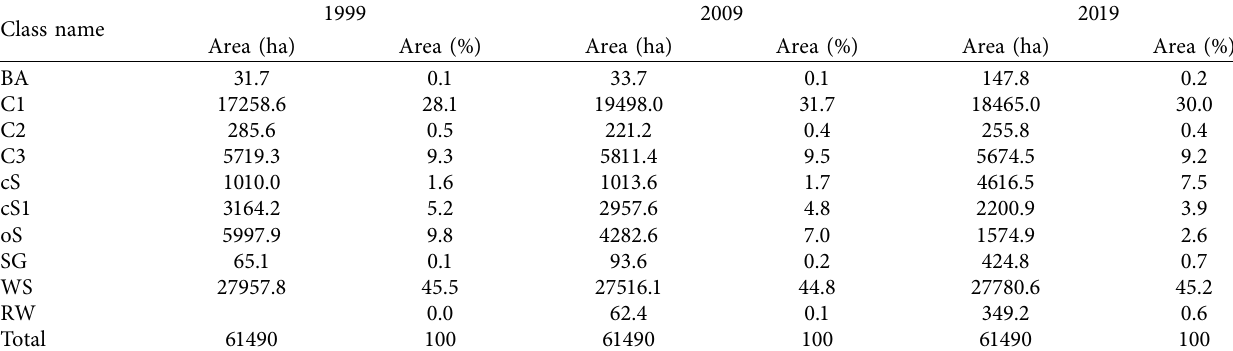
Figure 7: (a) LULC map in 1999. (b) LULC in map 2009. (c) LULC map in 2019. Table 4: LULC class transitions